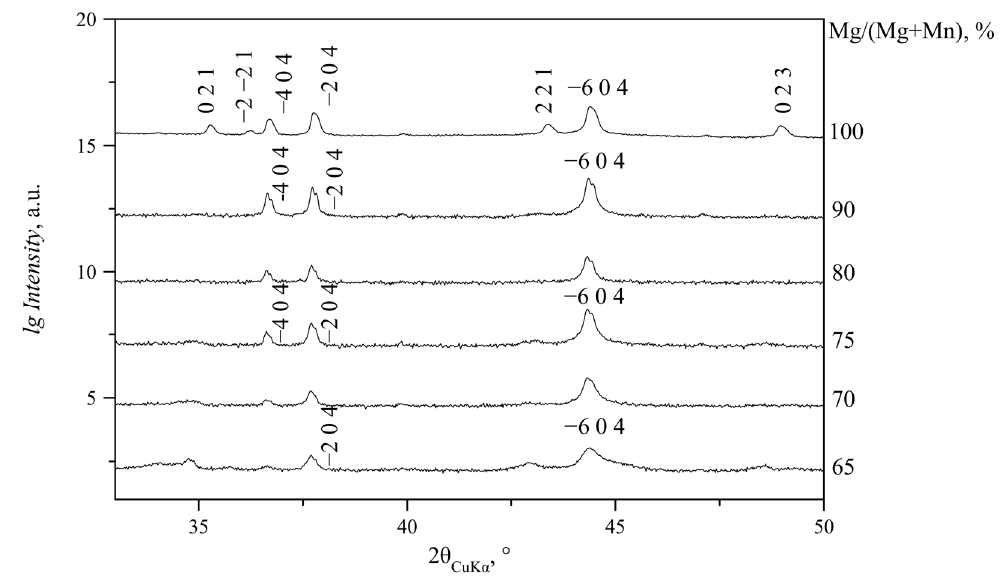
Figure 5. Figure 5. XRD patterns of precipitates obtained at Mg/(Mg + Mn) = 65–100% (N series, 2 θ CuK α = 33– 50°).